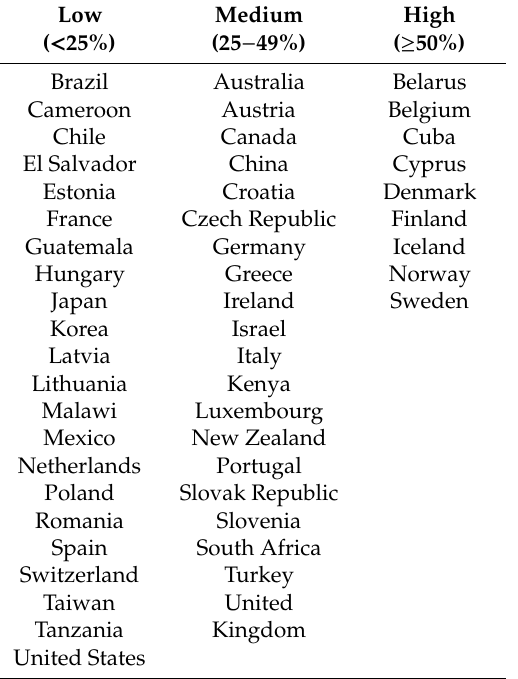
Table A2. Classification of Countries by Union